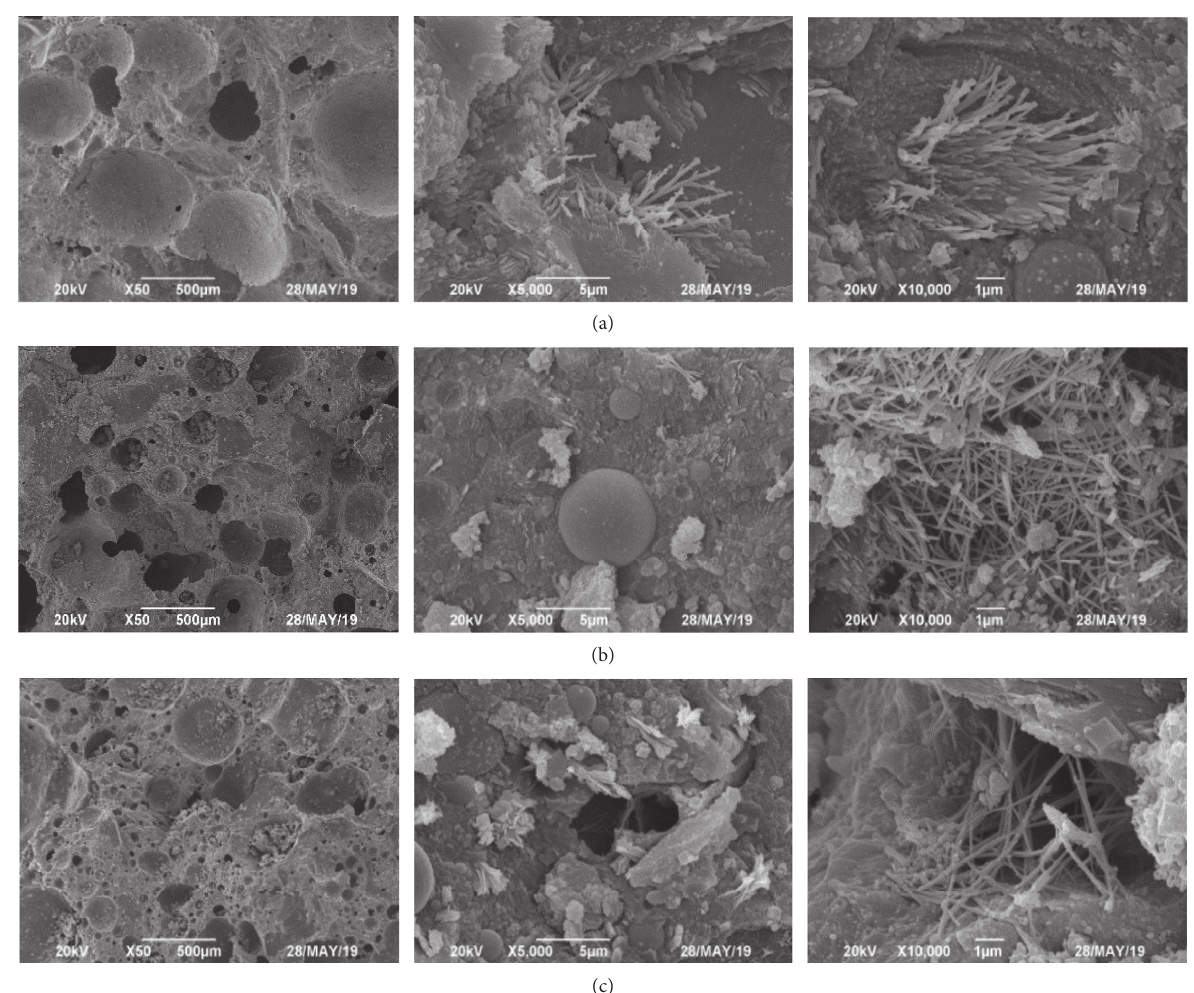
Figure 6: FC microstructures under SEM: (a) 1% NS; (b) 4% NS; (c) 5%